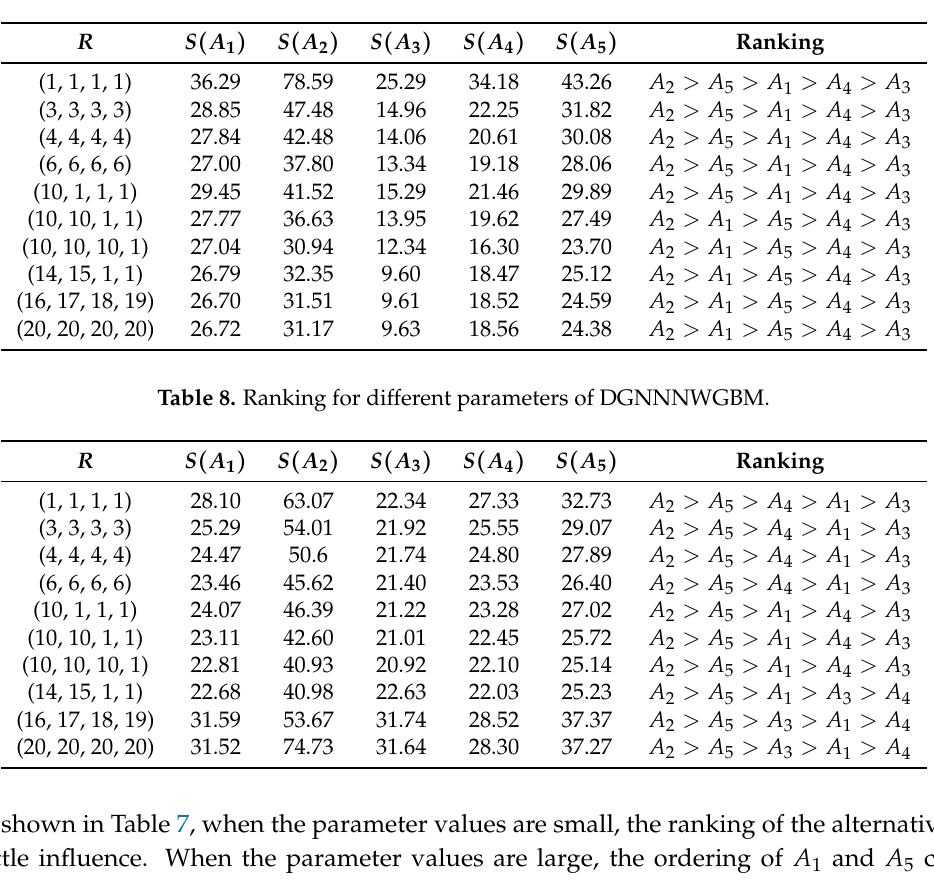
Table 7. Ranking for different parameters of DGNNNWBM.